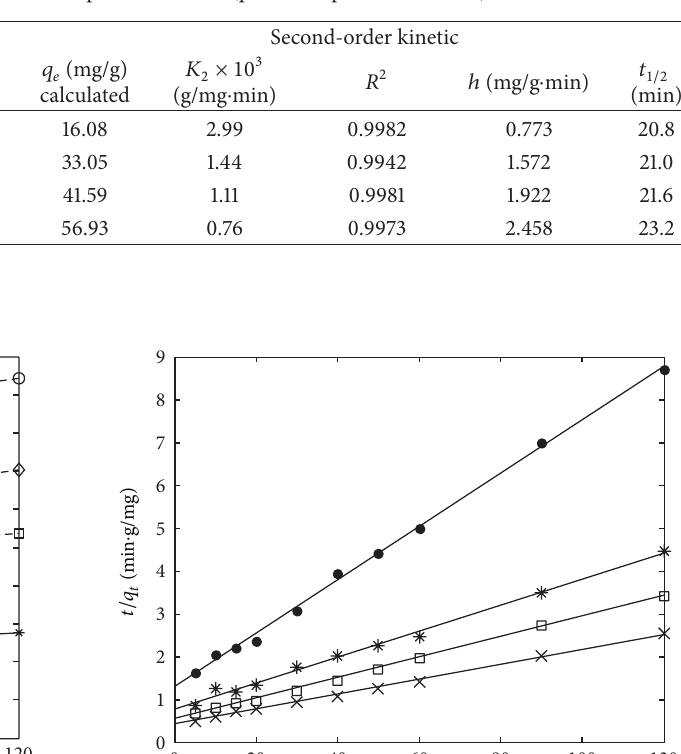
Table 5: Kinetic values calculated for MB adsorption on PTMF (pH-6, temperature = 303 K).